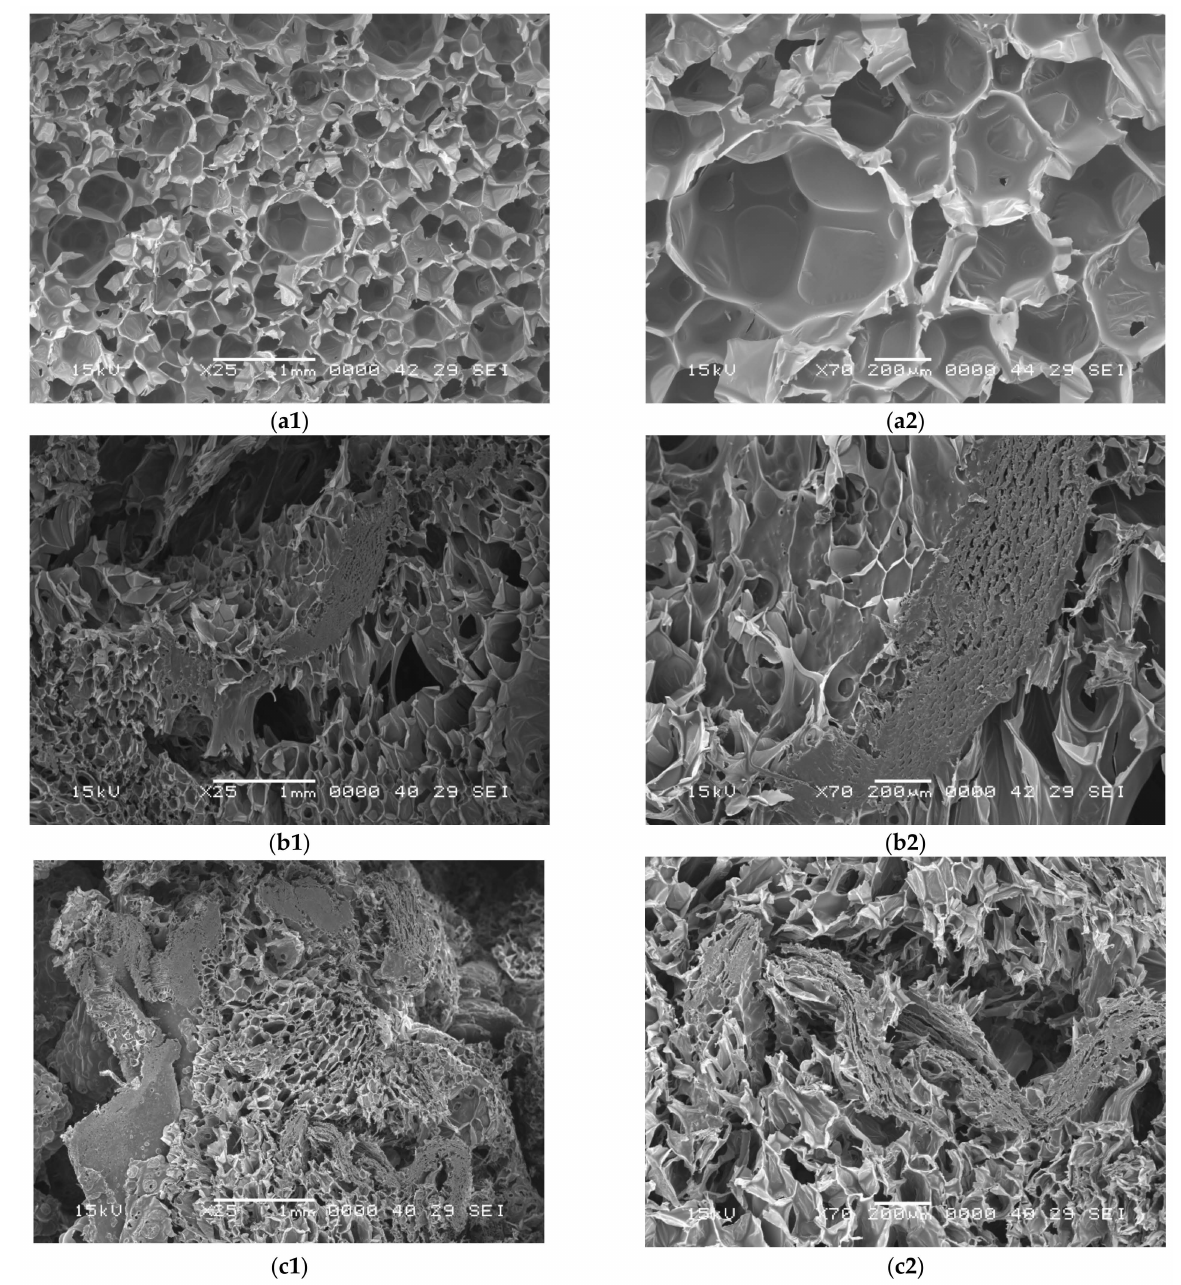
Figure 5. SEM images of obtained plates: ( a1,a2 ) RPUF-FS0-40. ( b1,b2 ) RPUF-FS35-40. ( c1,c2 )